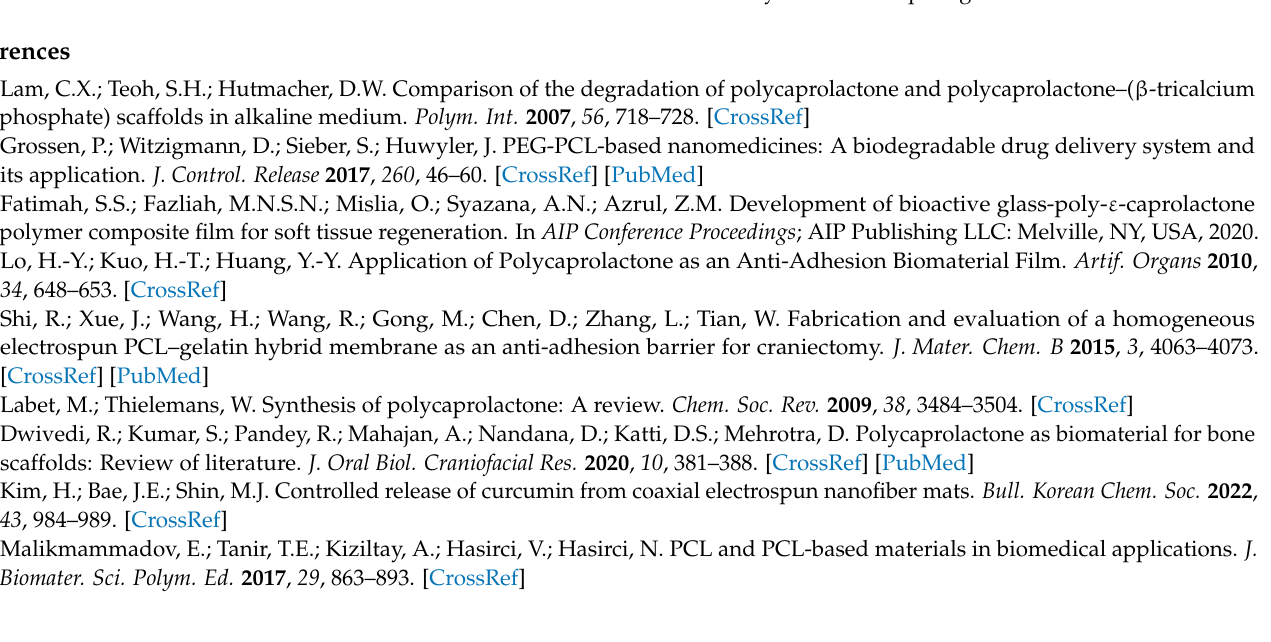
the experiment; Table S2: Average conductance and viscosity of AZ additive added PCL; Table S3: Average conductance and viscosity of QC additive added PCL; Table S4: Average conductance and viscosity of OA additive added PCL; Table S5: Average conductance and viscosity of GA additive added PCL; Table S6: Average conductance and viscosity of CH additive added